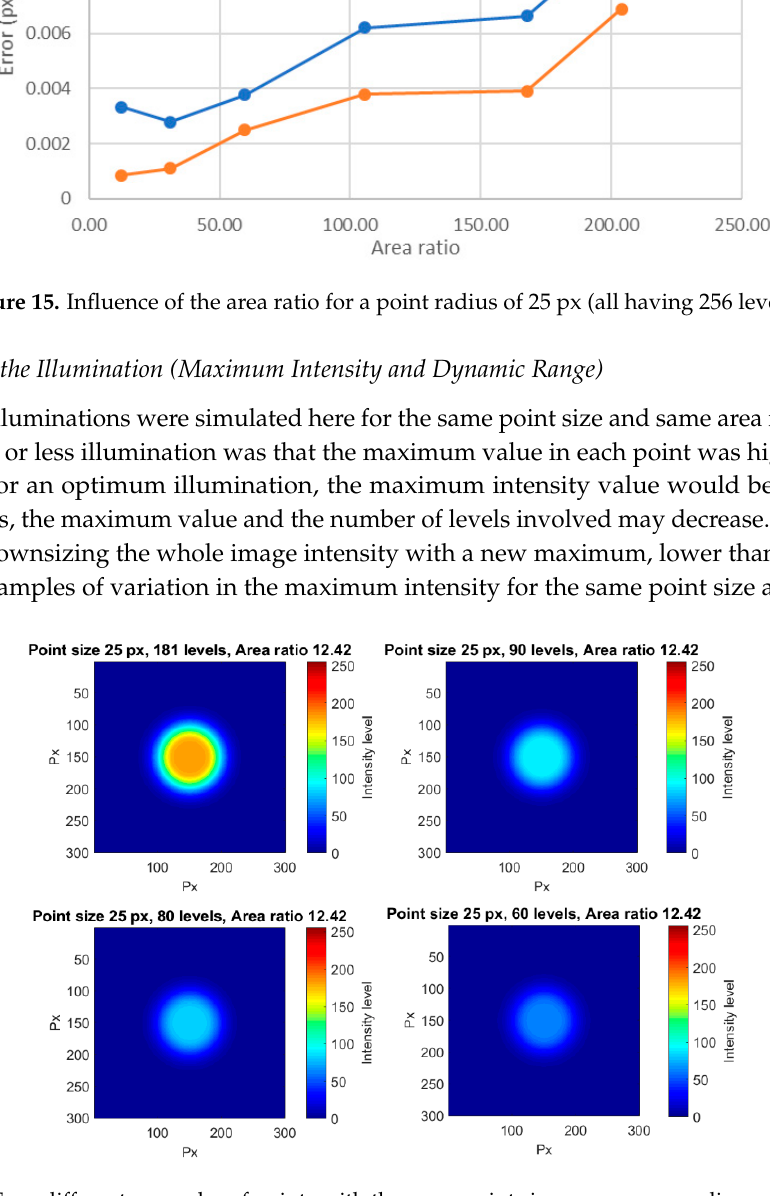
Figure 16. Four different examples of points with the same point size, same surrounding gradient, and different maximum intensity levels.